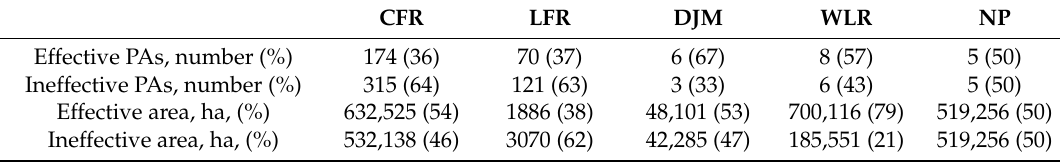
Table 3. Summary of PA effectiveness, in terms of number and area, and corresponding proportion (%).